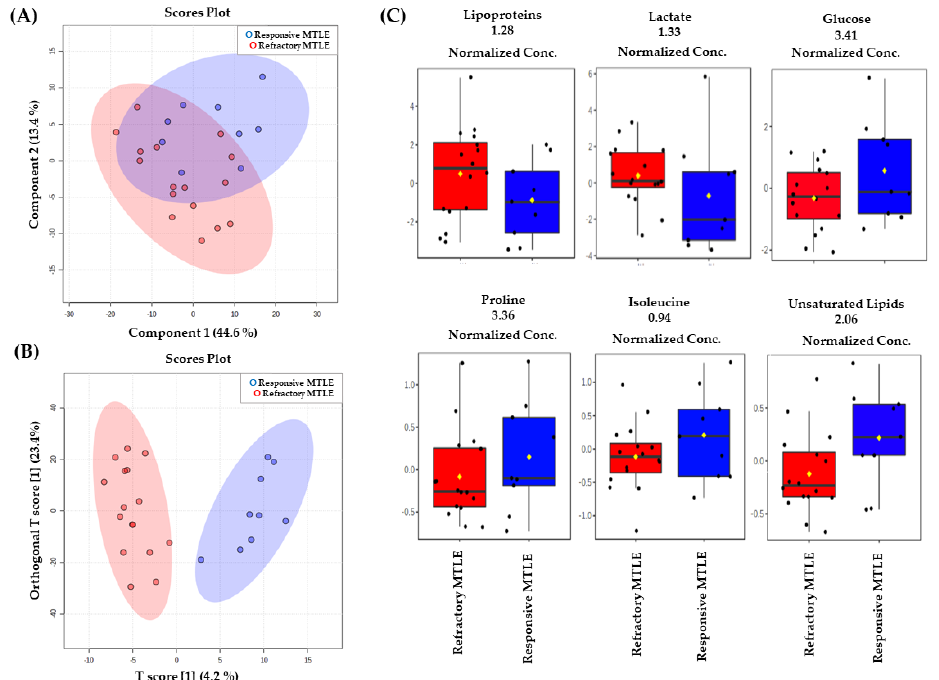
Figure A3. Multivariate analysis of 1 H-NMR (CPMG) plasma spectra of responsive and refractory MTLE patients. ( A ) PLS-DA analysis with the accuracy of 44.6%, R2 0.13, and Q2 − 0.19. ( B ) O-PLS- DA analysis. The information about response to treatment with ASM in patients with MTLE was not implemented into the models. ( C ) Box plots representing the variations of the relative concentrations (measured as peak intensities) of metabolites whose VIP scores > 2 according to PLS-DA results. The black dots represent the metabolite levels in all samples, and the yellow diamond represents the average value. Responsive MTLE (blue) and refractory MTLE